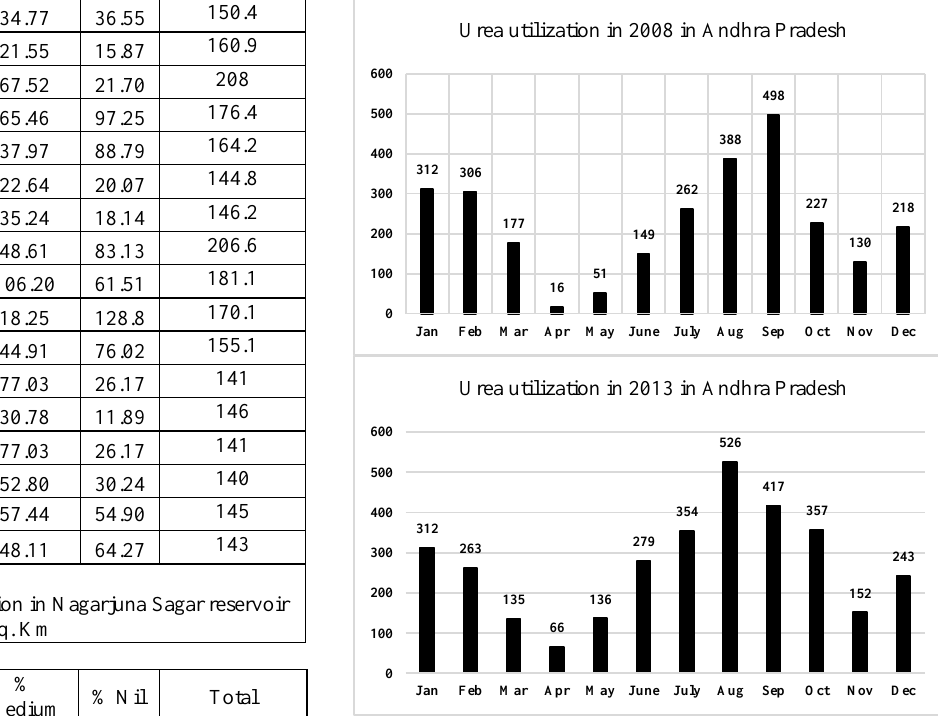
Figure 4. Urea added to agricultural fields during 2008 and 2013 in Andhra Pradesh.